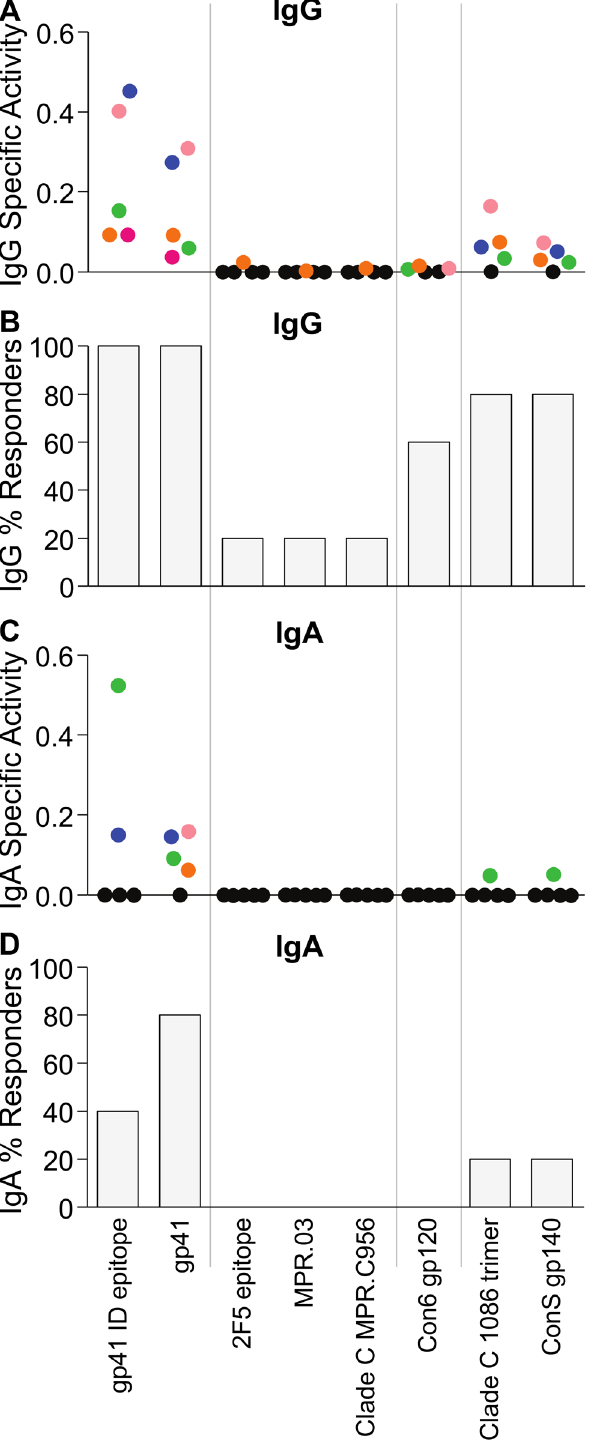
Figure 2. HIV-1 infection induces a broader range of HIV-1 Env- specific IgG than IgA antibodies in vaginal secretions. Vaginal secretions were collected from 5 HIV-1 infected women and analyzed for IgG (A–B) and IgA (C–D) binding to the indicated HIV-1 Env antigens. Antigens not specified as Clade C or consensus (Con6 and ConS) are derived from Clade B viruses. (A) Average HIV-1 antigen-specific IgG activity from the combination of the three sampling devices and two time points, calculated as antigen-specific MFI/ng ml 2 1 total IgG. Black symbols represent negative responses and colored symbols indicate